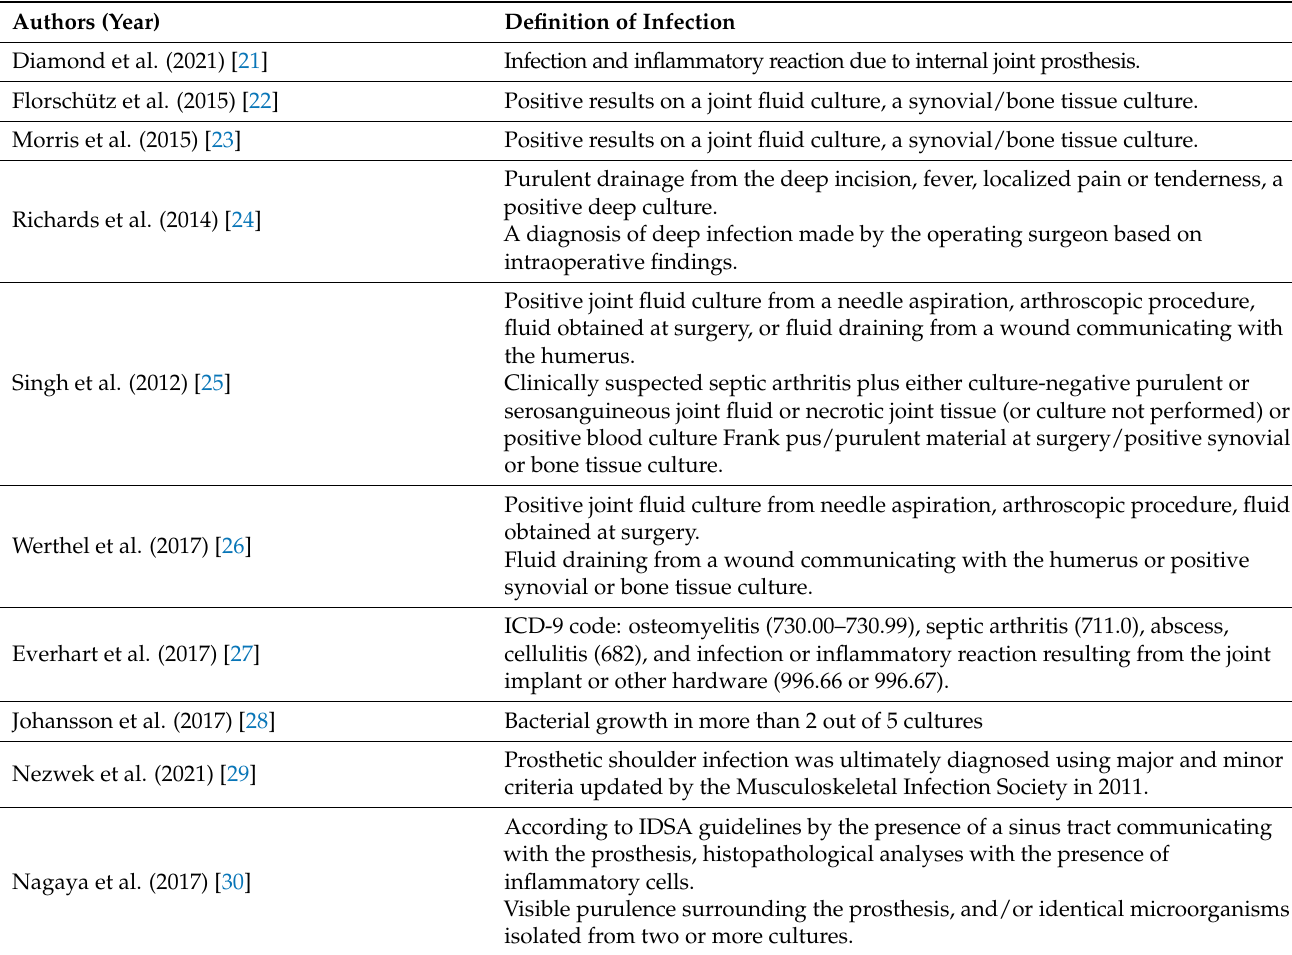
Table 1. Definition of infection described in